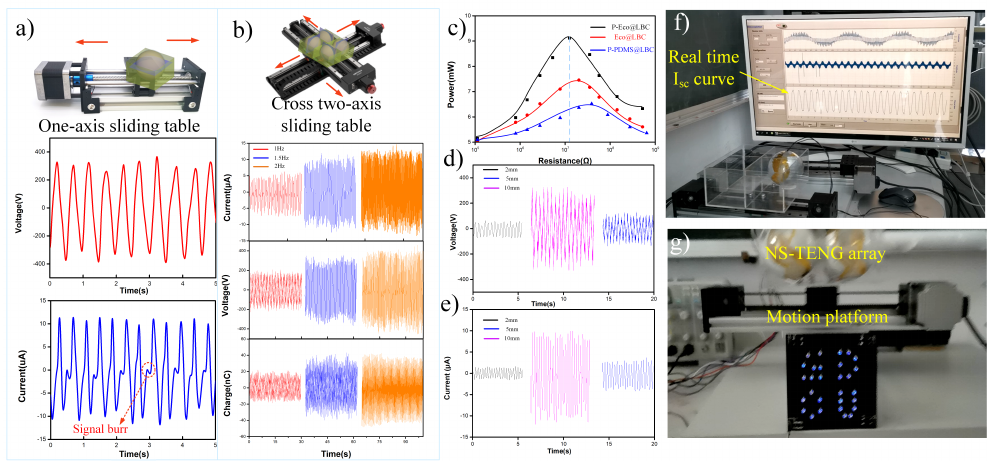
Figure 3. Output performance characterization of NS-TENGs. ( a ) Single guide rail and stepper motor drive setup and outputs of the NS-TENG at 2 Hz. ( b ) The NS-TENG array (2 × 2) experimental setup and outputs at various frequencies. ( c ) The output power comparison of the NS-TENG with various cores at 2 Hz ( d , e ). The electrical output comparisons between various thicknesses of the LBC’s coating film at 2 Hz. ( f ) Demonstrations of the NS-TENG’s electric outputs. ( g ) Photograph of the 2 × 2 NS-TENG array as a power source to light the LEDs in the